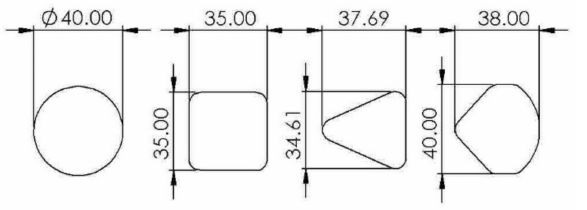
Figure 6. Top tube cross-sections from left to right: circular 40 mm, rectangular 35 × 35 mm, triangular, and complex.